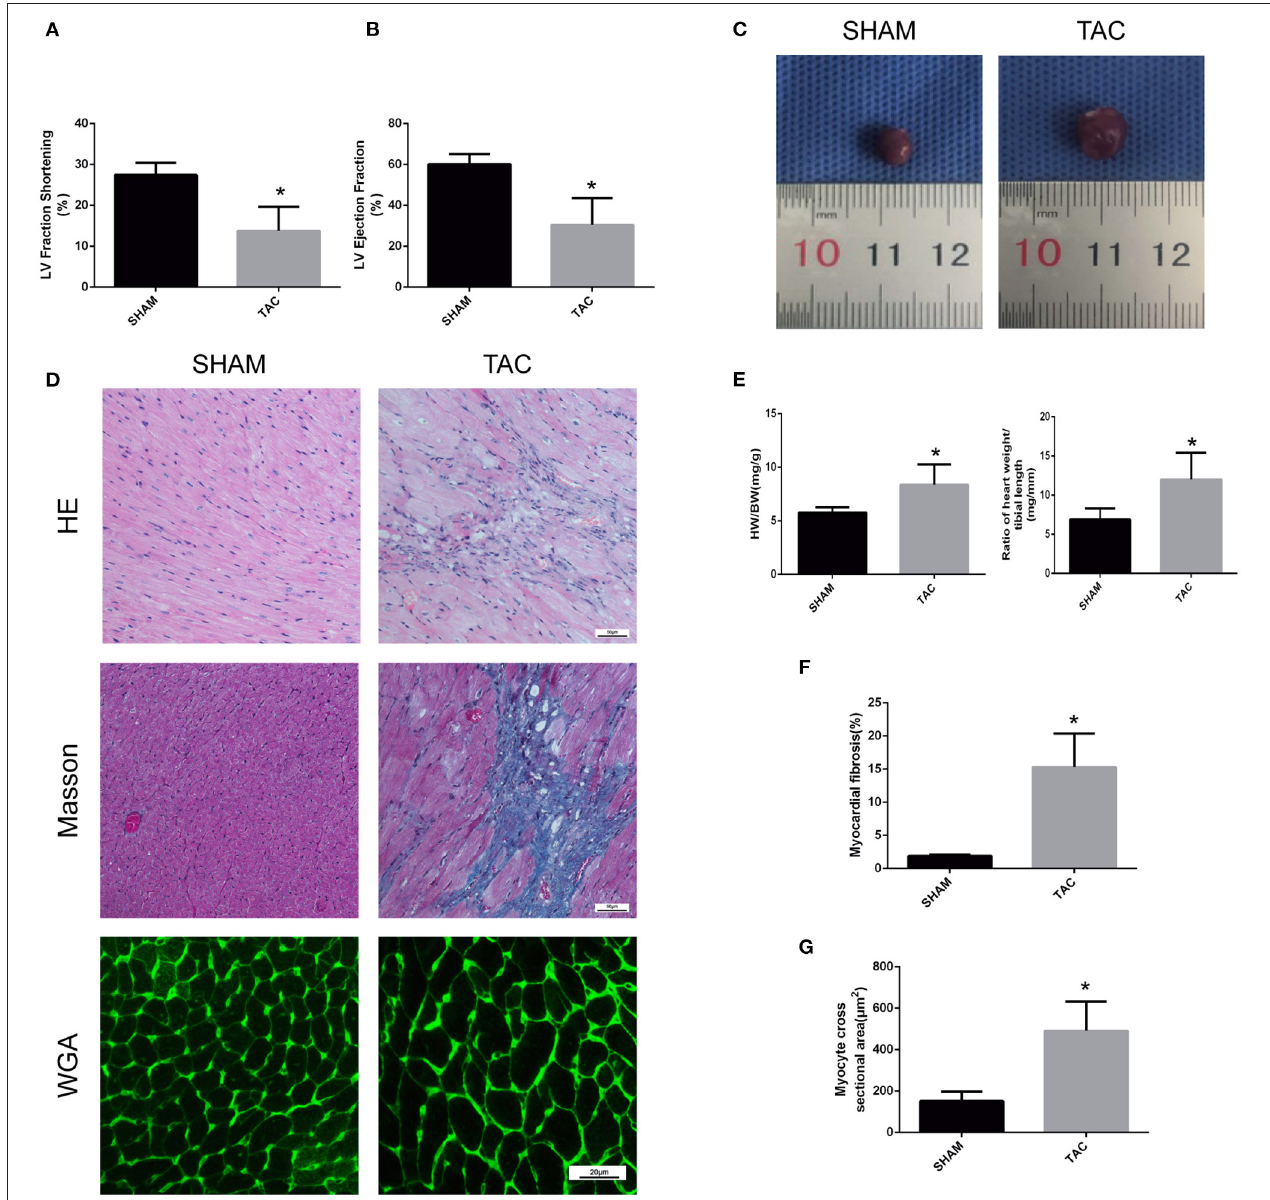
FIGURE 2 | Functional and pathological analysis of heart tissues in TAC mice. (A,B) Left ventricular fraction shorting and ejection fraction. (C) Heart size. (D) Representative HE- and Masson-stained myocardial sections. WGA-stained myocardial sections were used to measure myocyte cross sectional area. (E) The heart weight/body weight and heart weight/tibia length ratios of TAC mice. (F) Quantitative data of myocardial fibrosis (%). (G) Quantitative data of myocyte cross sectional areas. * P < 0.05.